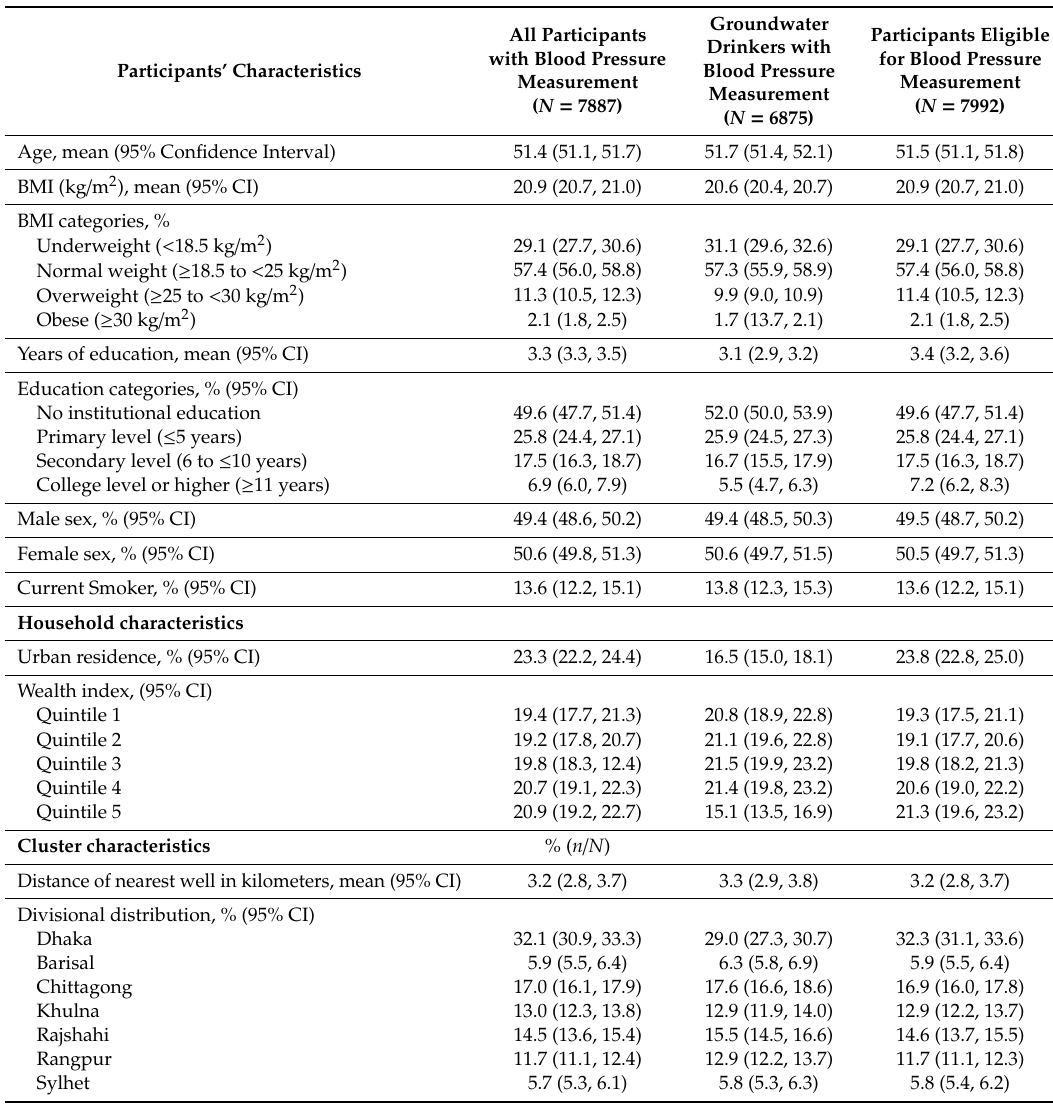
Table 1. Characteristics of the ≥ 35-year-old participants with blood pressure measurements in the Bangladesh Demographic and Health Survey (BDHS)